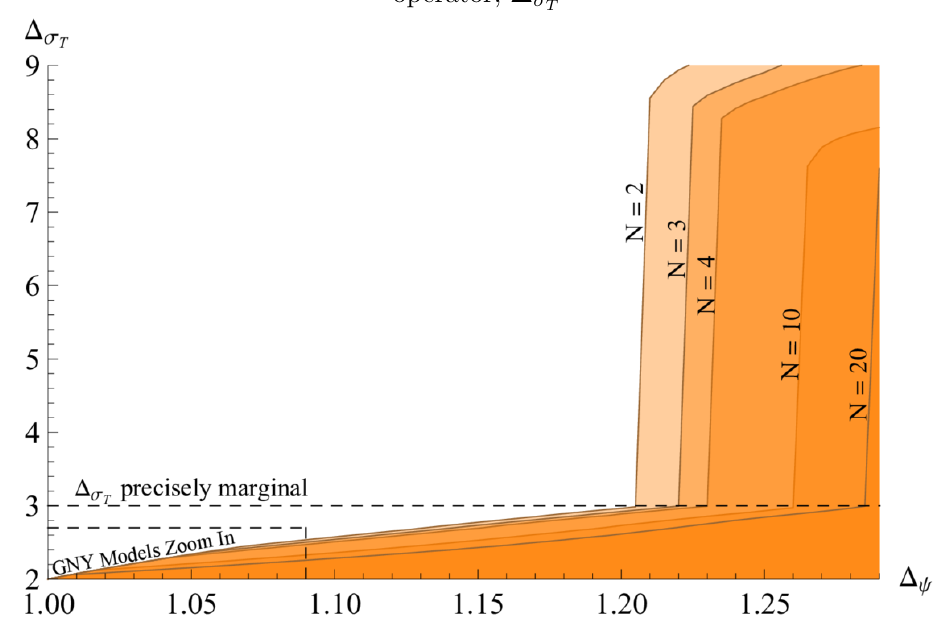
Figure 5 . Upper bounds on the scaling dimension of the lowest-lying parity-odd O ( N ) symmetric- traceless tensor, (cid:1) (cid:27) , for a unitary CFT containing fermions with scaling dimension (cid:1) . T